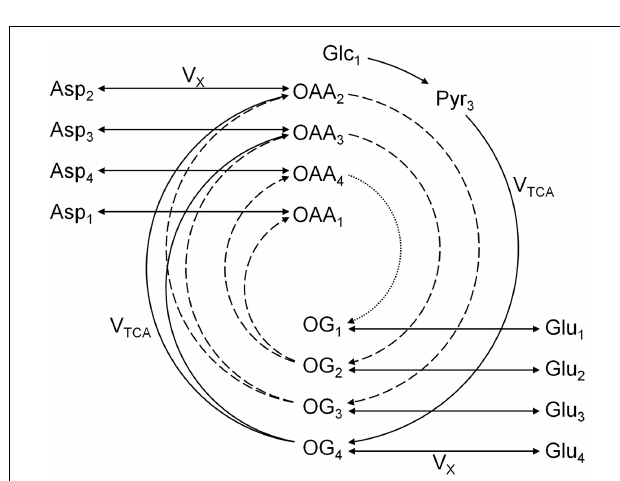
FIGURE 3 | Schematic view of the Monte Carlo analysis used in metabolic modeling to estimate the variance of the adjusted parameters .The metabolic model is first fitted to the experimental data, giving an optimal parameter set and the related model turnover curves that best describe the data. From the fit residual, the noise level of the different turnover curves is estimated. Artificial datasets (typically several hundreds) are then generated by adding different noise realizations to the